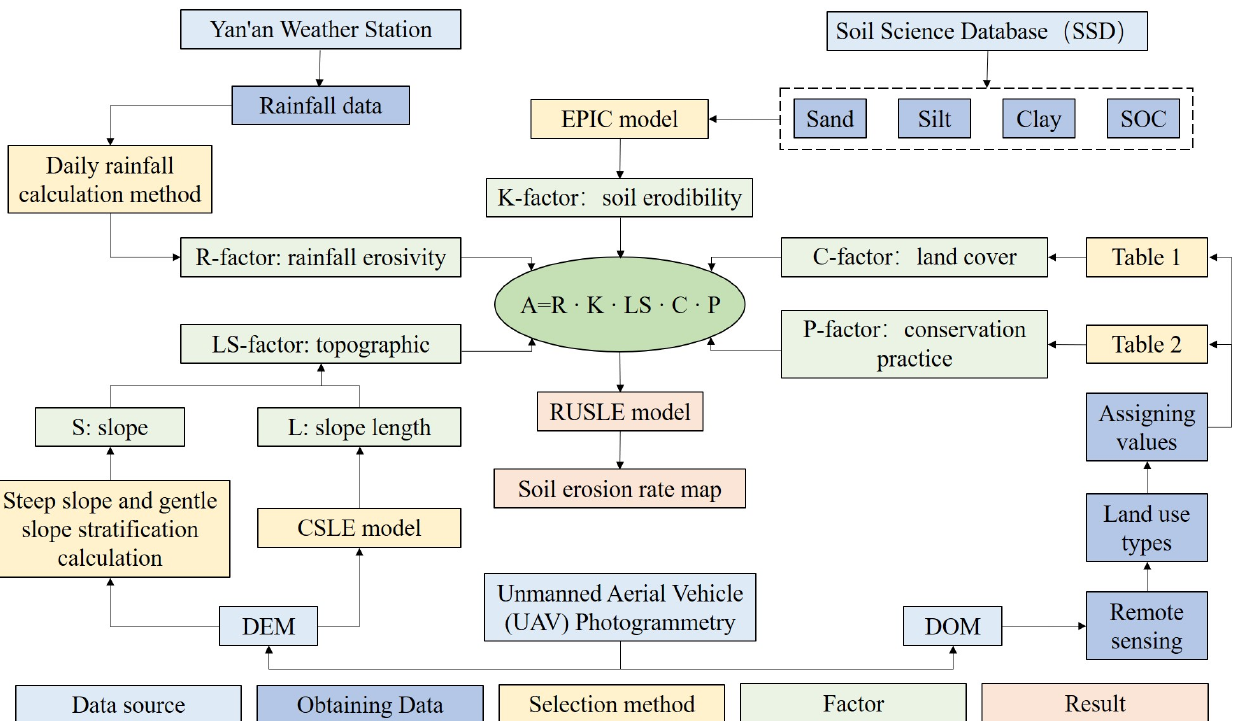
Figure 4. Calculation method and parameter values of the RUSLE model. All factors and abbrevia- tions are defined in the text